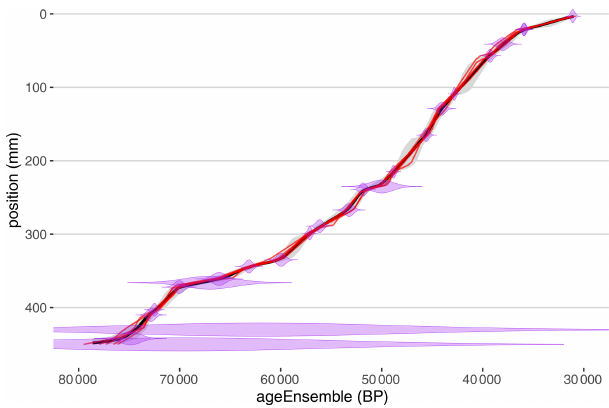
Figure 2. Age–depth model generated by BChron for a speleothem from Hulu Cave. Relative age probability distributions are shown in purple. Median age–depth relationship is in black, with 50th and 95th percentile highest-density probability ranges shown in dark and light gray, respectively. Five random age–depth ensemble mem- bers are shown in red.